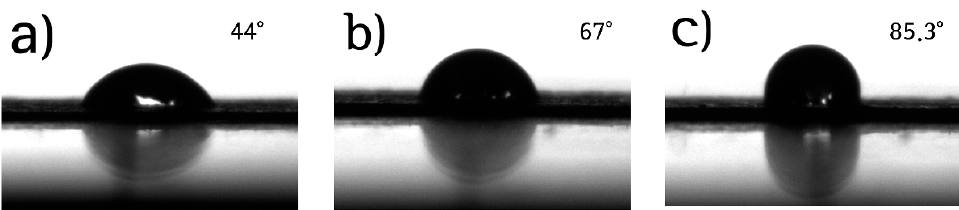
Figure 4. Contact angle measurement for ( a ) Mo 2 C/N,S-C, ( b ) Mo 2 C/S-C, and ( c ) c-Mo 2 C.